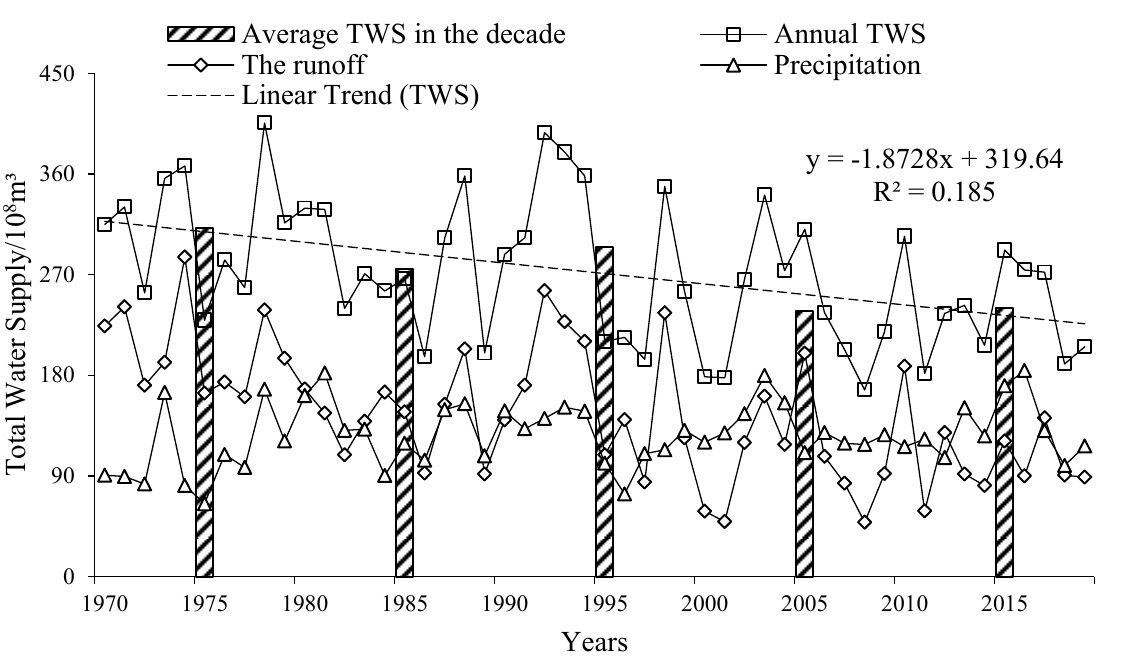
Figure 2. Variation of Total Water Supply during 1970 to 2019. Notes: TWS, total water supply. In the past 50 years, the average TWS was 271.88 × 10 8 m 3 , in which the runoff and precipitation accounted for 53.57% and 46.43%, respectively. The change of runoff was variable with time, the average runoff was 145.66 × 10 8 m 3 , showing a fluctuating decrease trend with a rate of 2.32 × 10 8 m 3 /y. In the 2010s, the amount of water flowing into the irrigation area and the Aral Sea was about 40% of that in the 1970s. The annual average precipitation was 126.22 × 10 8 m 3 , and the precipitation showed a trend of fluctuating in- crease with a rate of 0.51 × 10 8 m 3 /y, in which precipitation increased sharply in the 1970s to 1980s.